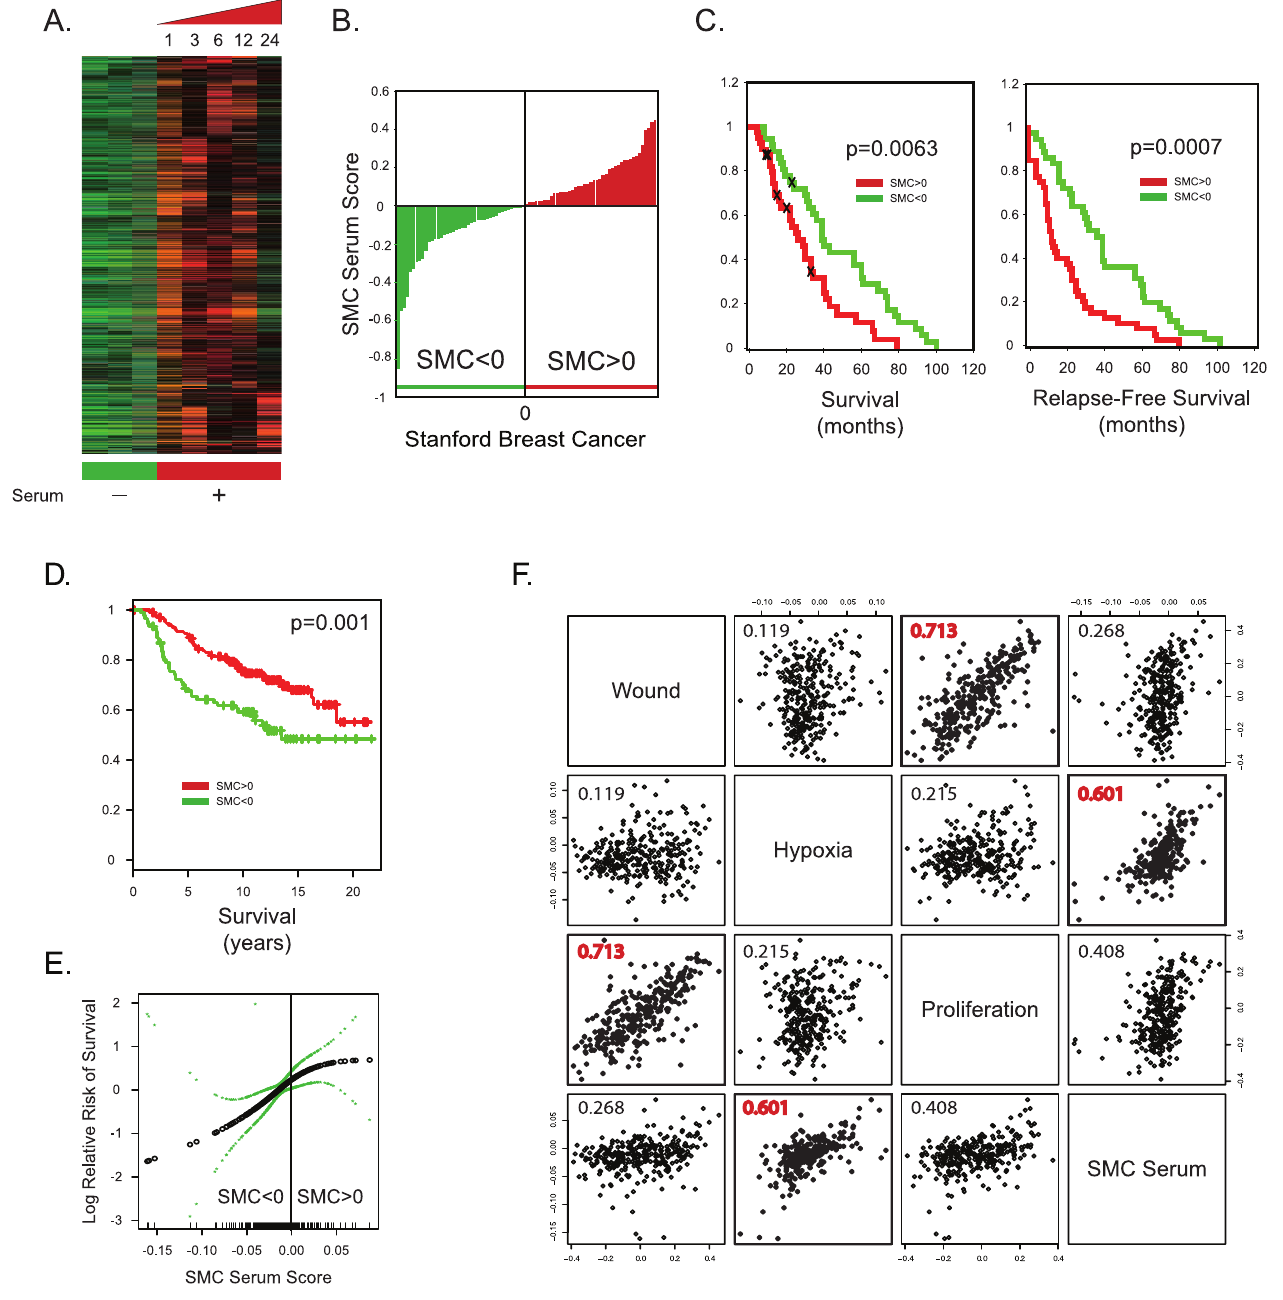
Figure 5. Analysis of Vascular SMC Serum Response and Its Prognostic Significance in Human Cancers (A, B) Expression of the 653 genes in the SMC serum-response signature in coronary SMCs before (green) and after (red) serum exposure at indicated time points (A). The SMC serum-response scores of the Stanford breast tumor collection (B) were calculated based on the average expression values of the serum-response signature genes. The tumors were separated based on whether SMC serum-response scores were positive (red, right) or negative (green, left). (C, D) With the threshold value of the SMC serum-response signature set at zero for classification of patients into high (red) and low (green) SMC serum- response groups, the Kaplan-Meier analysis shows significant differences in survival and time to recurrence between the two groups of samples in the Stanford (C) and NKI (D) breast cancer datasets. (E) Correlation of the quantitative and continuous SMC serum-response score ( x -axis) of each tumor sample (black circle) in the NKI breast cancer dataset versus the (log) relative risk ( y -axis) of mortality. (F) Scatter plots showing the relationship between the wound-response [66], hypoxia-response [36], proliferation [67], and SMC serum-response signatures. Each point in the scatter plots represents a single one of the 295 tumors analyzed in the NKI dataset. The overall correlation between each pair of expression signatures across this set of 295 samples is indicated in each panel.